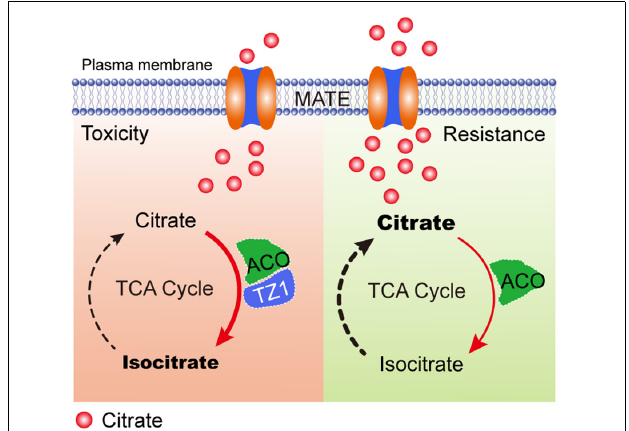
FIGURE 7 | A proposed model of TZ1 and ACO mediated Al-stress response to control root growth. In toxicity responses, TZ1 is induced by Al stress and the interaction with ACO enhances the conversion of citrate to isocitrate and slows down the plant growth. Under Al resistance condition, the decreased TZ1 releases ACO and thus reduces the activity of ACO, which finally results in the high citrate content and enhanced Al resistance and plant